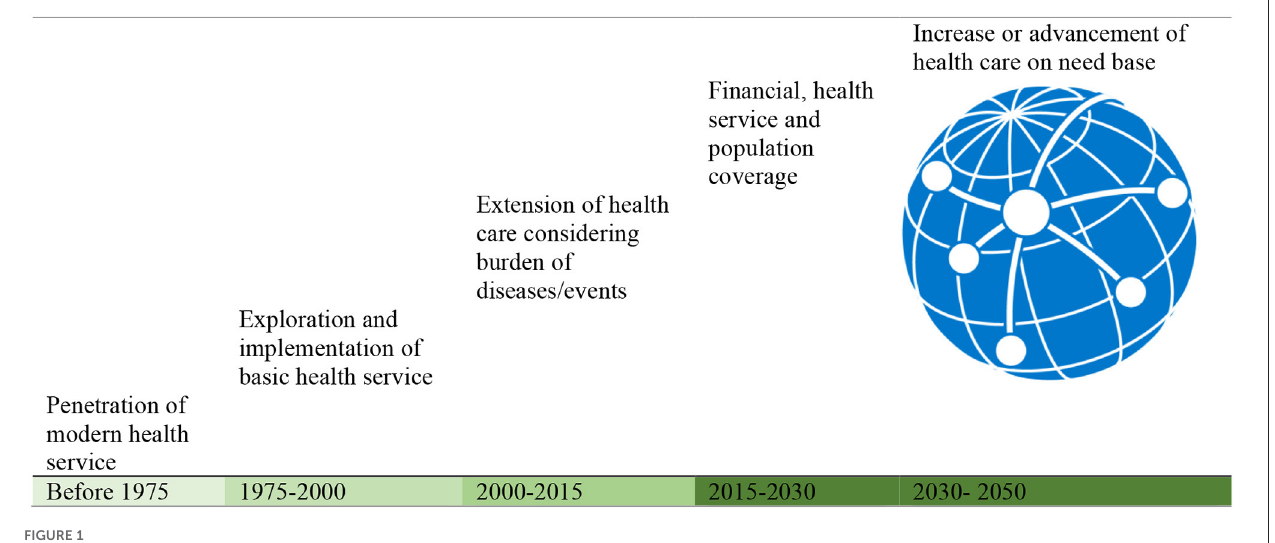
FIGURE1 Universal health coverage (UHC) evolution, development, and